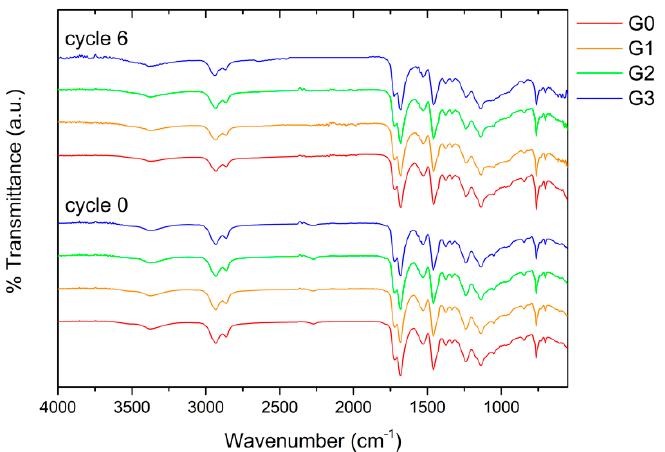
Figure 11. Evolution of the FTIR spectra of the samples before and after the 6 cycles of the accelerated degradation test.